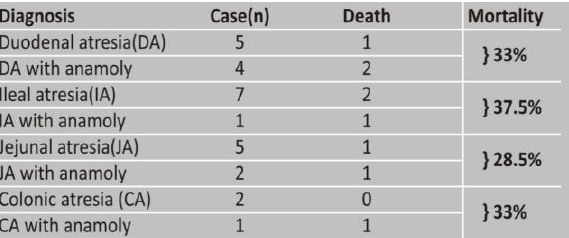
Table 2: Showing relationship of mortality with